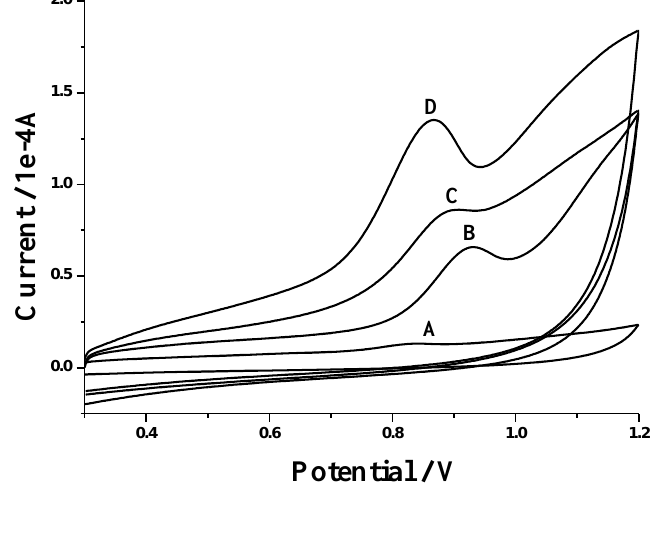
Figure 6. Cyclic voltammograms of 1.0 × 10 −5 M doxepin at bare GCE (A), poly(4-ABA)/GCE (B), MWNTs/GCE (C), and poly(4-ABA)/MWNTs/GCE (D). Scan rate: 100 mV s −1 ; supporting electrolyte: 0.10 M PBS (pH 6.2); accumulation time: 60